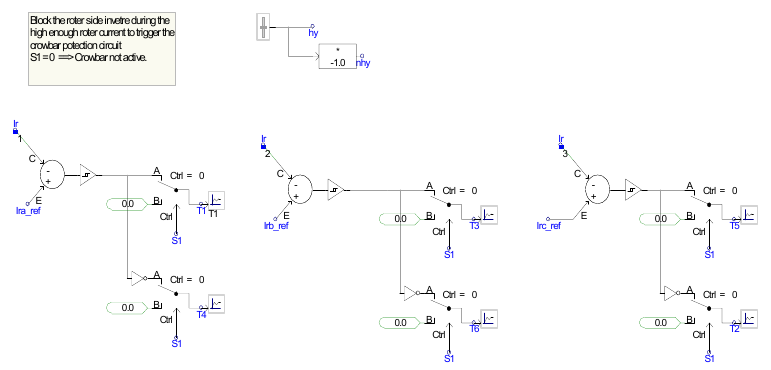
Figure A3. Hysteresis current control for firing IGBTs of rotor side converter.